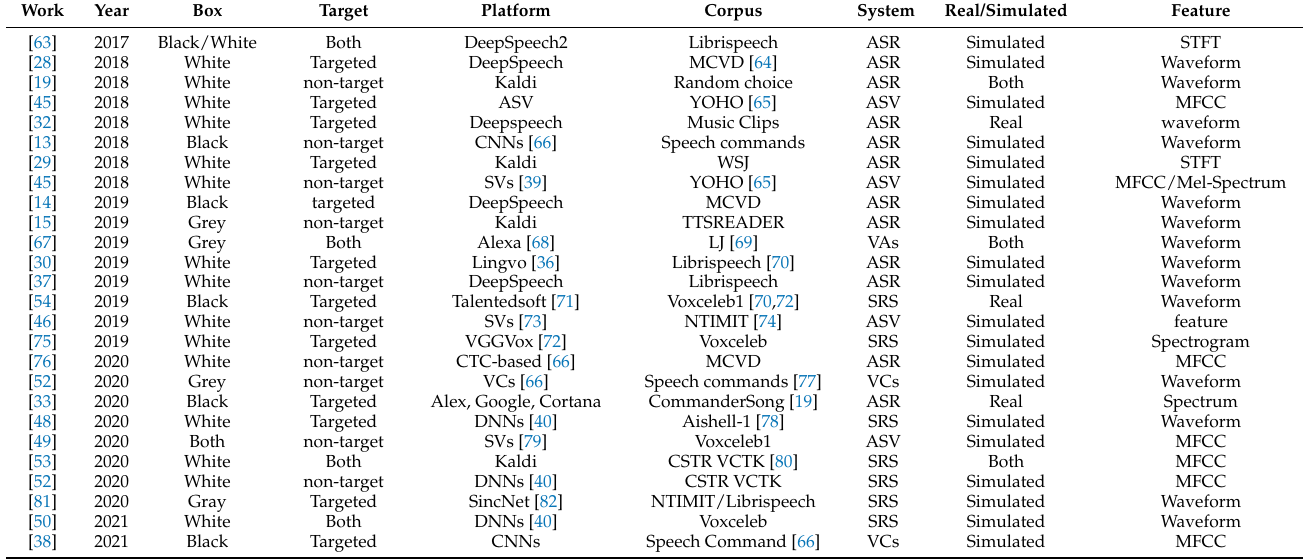
Table 1. The taxonomy of attack in speaker and speech recognition. ‘Box’ indicates the prior knowledge which the attacker master, which can be categorized by a white box, a gray box and a black box. ‘Platform’ is the certain attacked system. ‘System’ means the targeted system, especially the voice control system (VCs); ‘Real/Simulated’ shows whether the attack is in the real physical